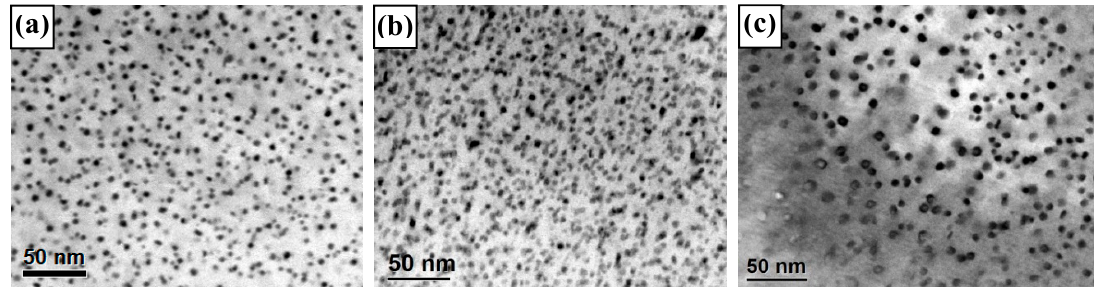
Figure 8. TEM (transmission electron microscope) images of the weld center aged at different temperatures for 24 h ( a ) 120 °C; ( b ) 130 °C; ( c ) 140 °C.